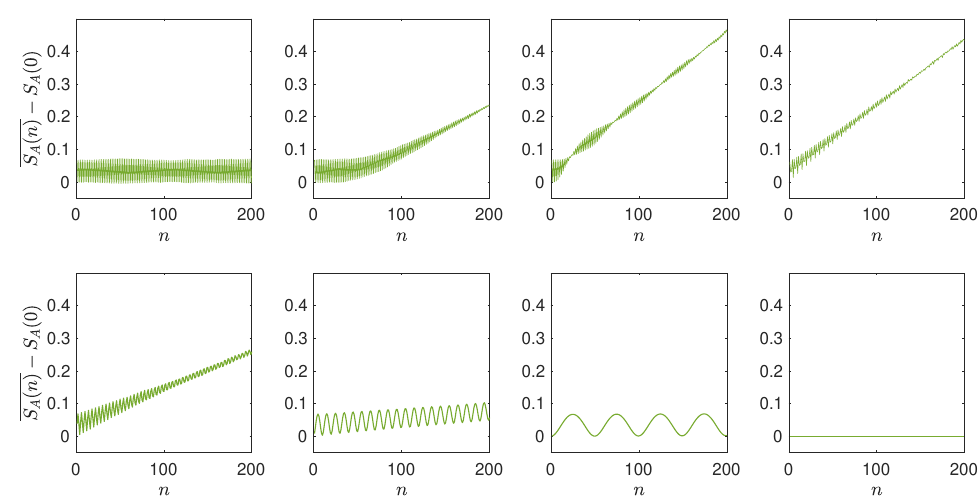
Figure 7: Ensemble-averaged entanglement entropy evolution in a randomly driven CFT, with A = [ kl − l / 2, kl + l / 2 ] where k ∈ (cid:90) . We consider the driving protocol 2 by choosing θ randomly distributed in [ 0,0.2 ] in (34). From left to right (and − 1 / 2 = 0, 0.0005, 0.01, 0.1, then top to bottom), we choose ∆ T / l : = T θ / l θ eff ,eff = 0 corresponds to the 0.25, 0.4, 0.48, and 0.5, respectively. It is noted that ∆ T / l eff = 0.5 corresponds to the trivial point. In this type I exceptional point and ∆ T / l eff plot, for comparison we show the time evolution for a fixed time window, which may be too small to see the linear slope for cases with small growth rate, e.g. the plot = 0.48 is indeed growing when we zoom out the time window. Other for ∆ T / l eff = 10 4 , c = 1 and l = parameters are N sample